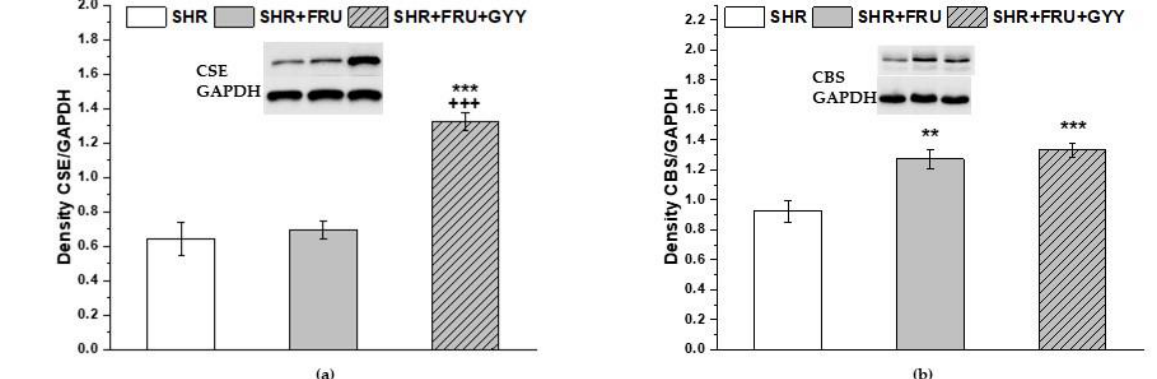
Figure 11. The expression of H 2 S-producing enzymes CSE ( a ) and CBS ( b ) in the left ventricle. Tissue was isolated from spontaneously hypertensive rats (SHRs), SHRs treated with fructose (SHR+FRU), and SHRs treated with fructose and GYY-4137 (SHR+FRU+GYY). CSE—cystathionine γ -lyase; CBS—cystathionine β -synthase. Data are expressed as the mean ± S.E.M. Statistical analysis was performed by one-way ANOVA. ** p < 0.01 and *** p < 0.001 vs. SHR, +++ p < 0.001 vs. SHR+FRU.